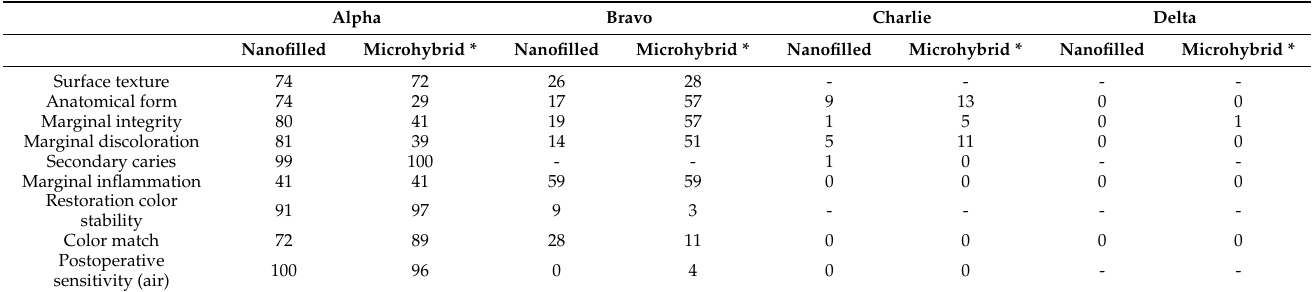
Table 5. Results of the USPHS evaluation of the second study cohort (nanofilled composite restorations) after a mean restoration service time of 5.2 years, and of the first study cohort (microhybrid composite restorations) after a similar restoration service time *. The percentages of the respective ratings (alpha–delta) for the different categories of the clinical evaluation are given.